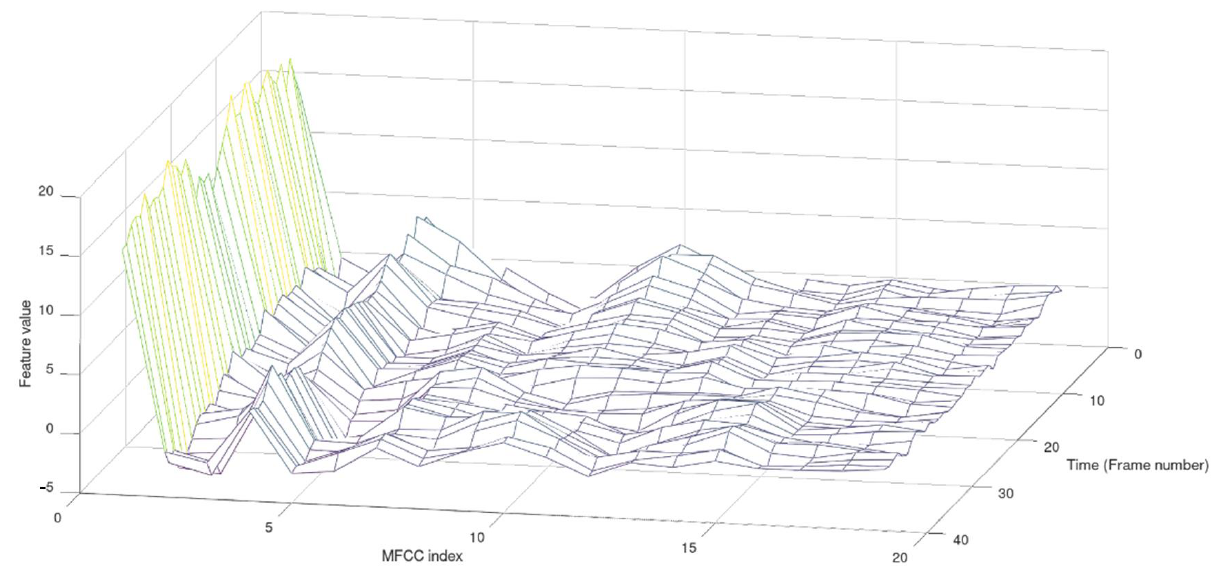
Figure 10. MFCC features of the Seg 1 (“buł”) of word bread roll (“bułka”)—man after laryngectomy.